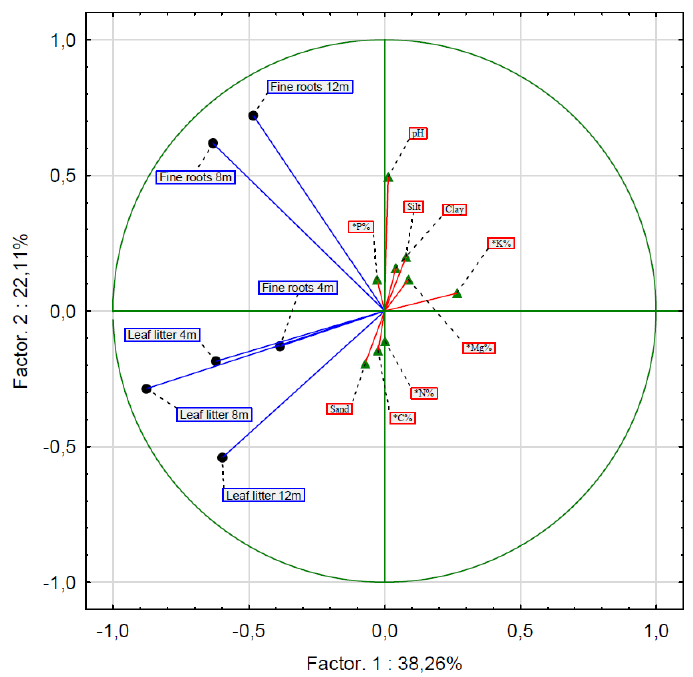
Figure 3. Principal components analysis to determine the factors influencing the distribution of the biomass of fine roots and leaf litter (* Chemical properties of soils). Table 1. Basic soil properties under birch, larch, and pine growing on reconstructed forest ecosys- tem (PM), regenerated forest ecosystem (PF), and control plots (CS) (mean ± SE) [43].